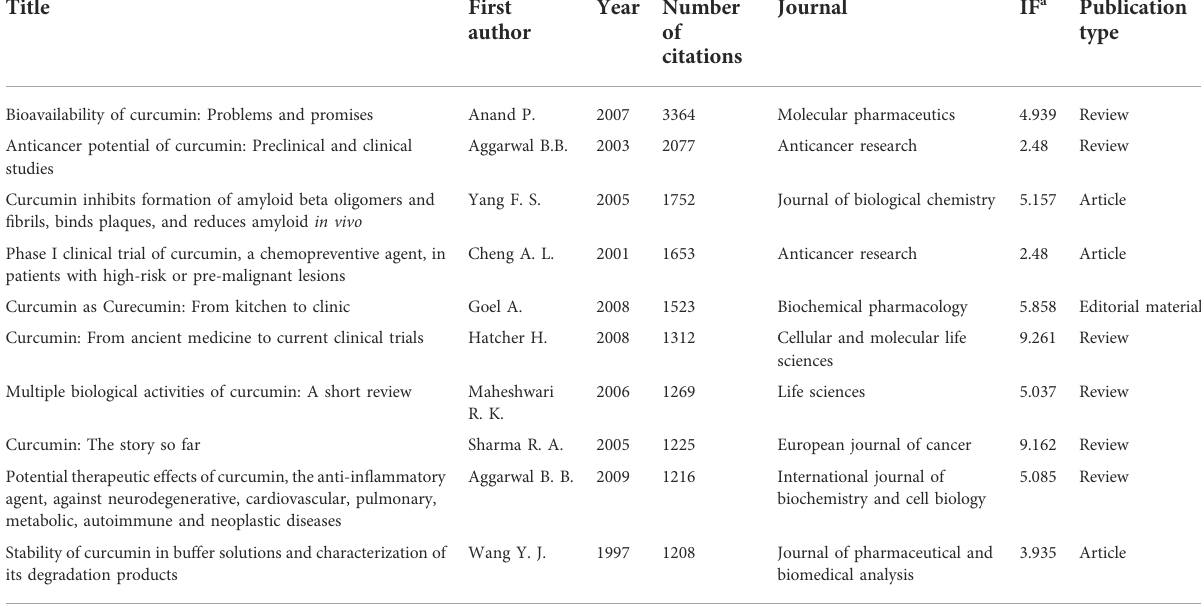
52 keywords met the threshold. The network visualization diagram shows the co-occurrence relations of keywords